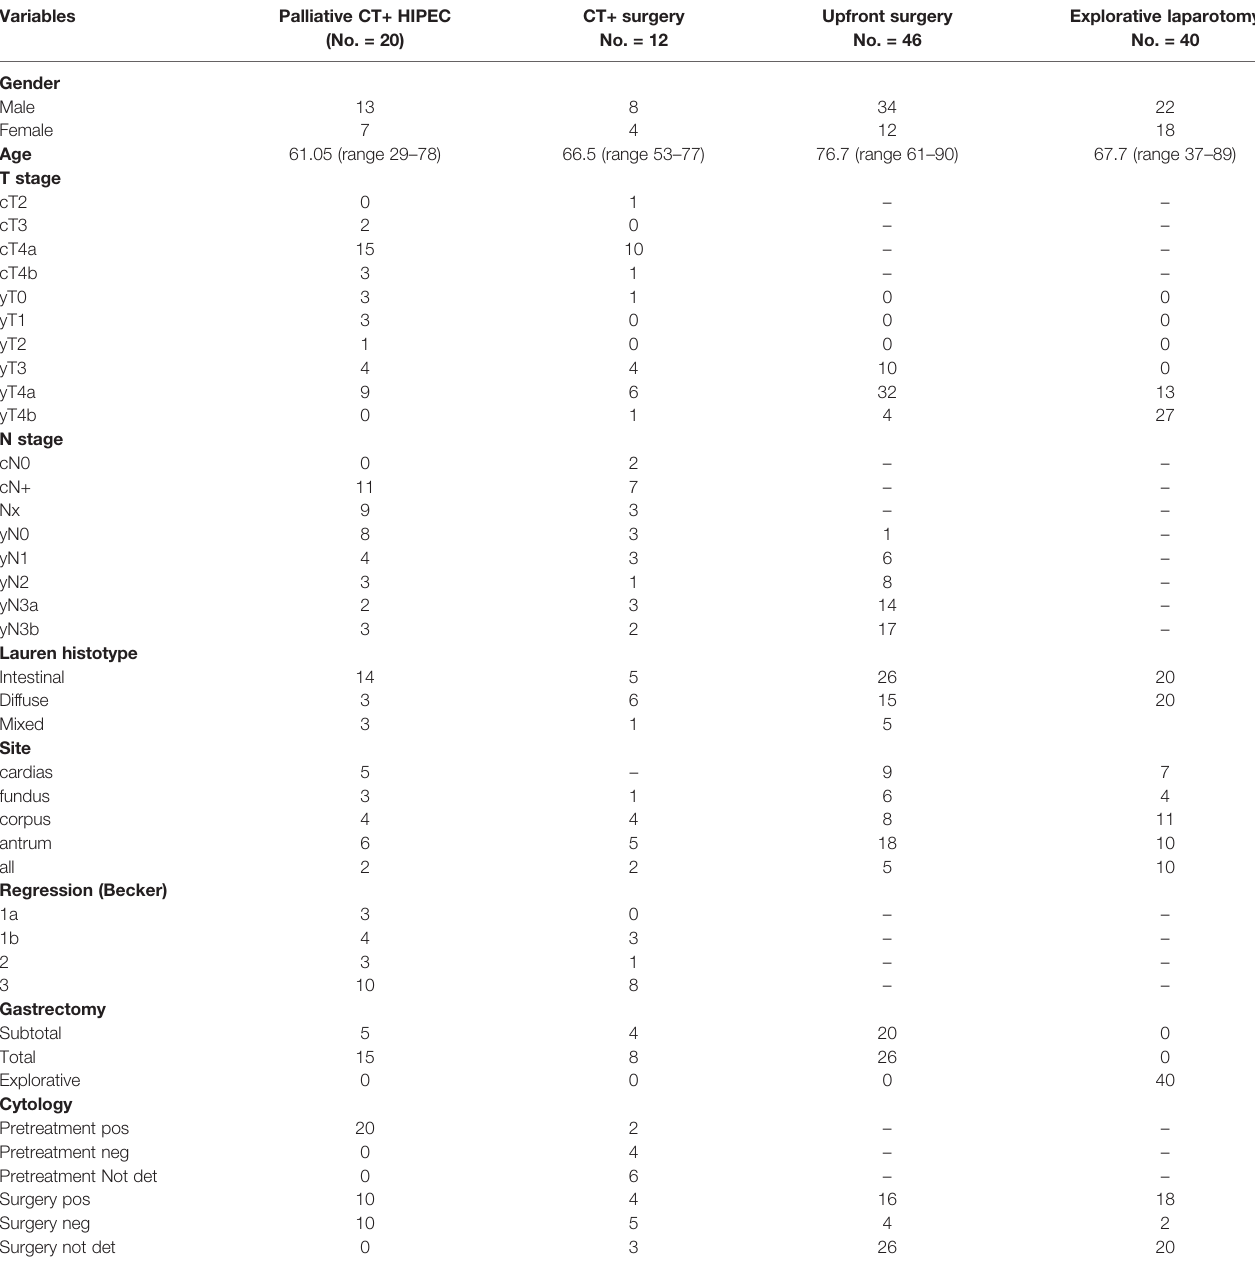
TABLE 1 | Patients ’